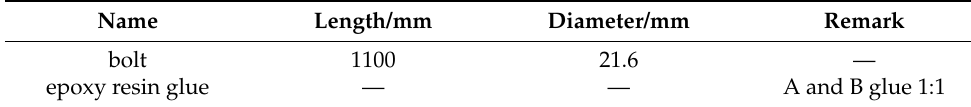
Table 1. Roadway geotechnical properties.